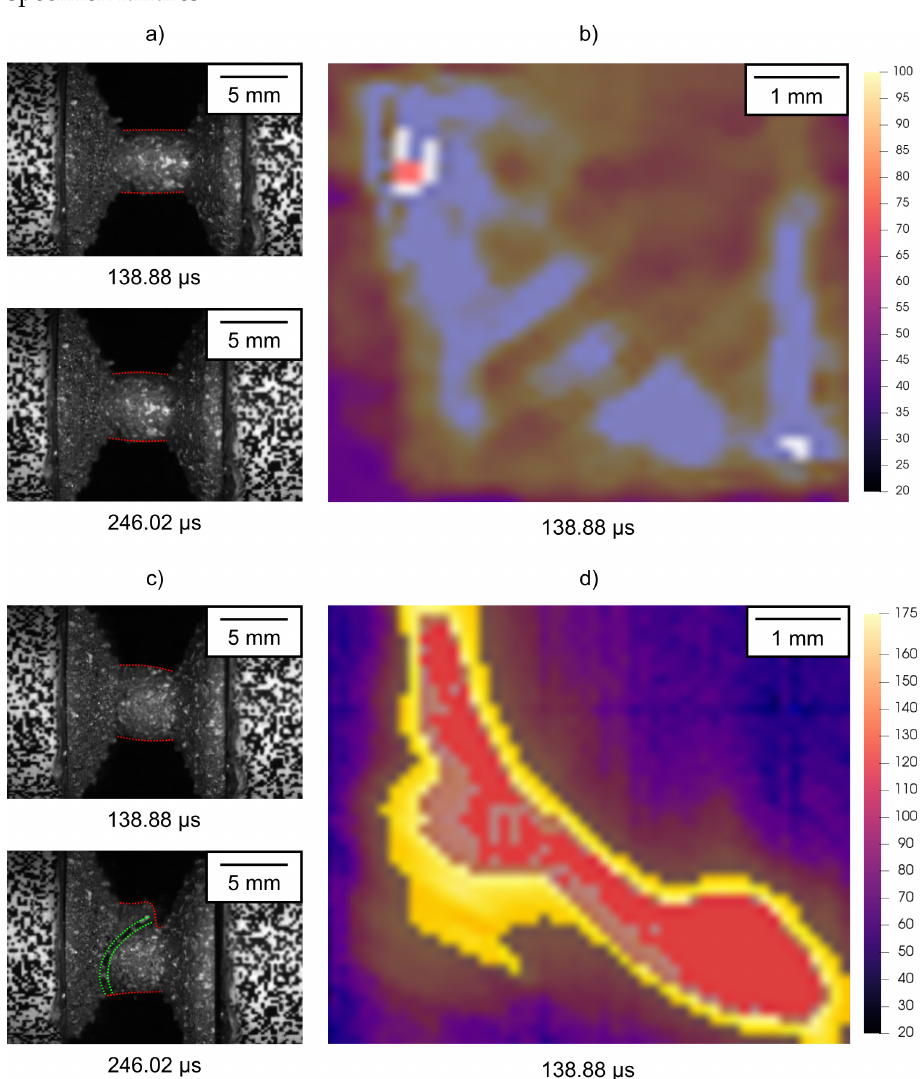
Figure 11. Different behaviour of the specimen with a 0 ◦ degree orientation showing the thermograms ( b , d ) and visible-light images ( a , c ) captured at 138.88 µ s together with the visible light images captured at 246.02 µ s revealing the different thermal response of the samples in dependence on the damage